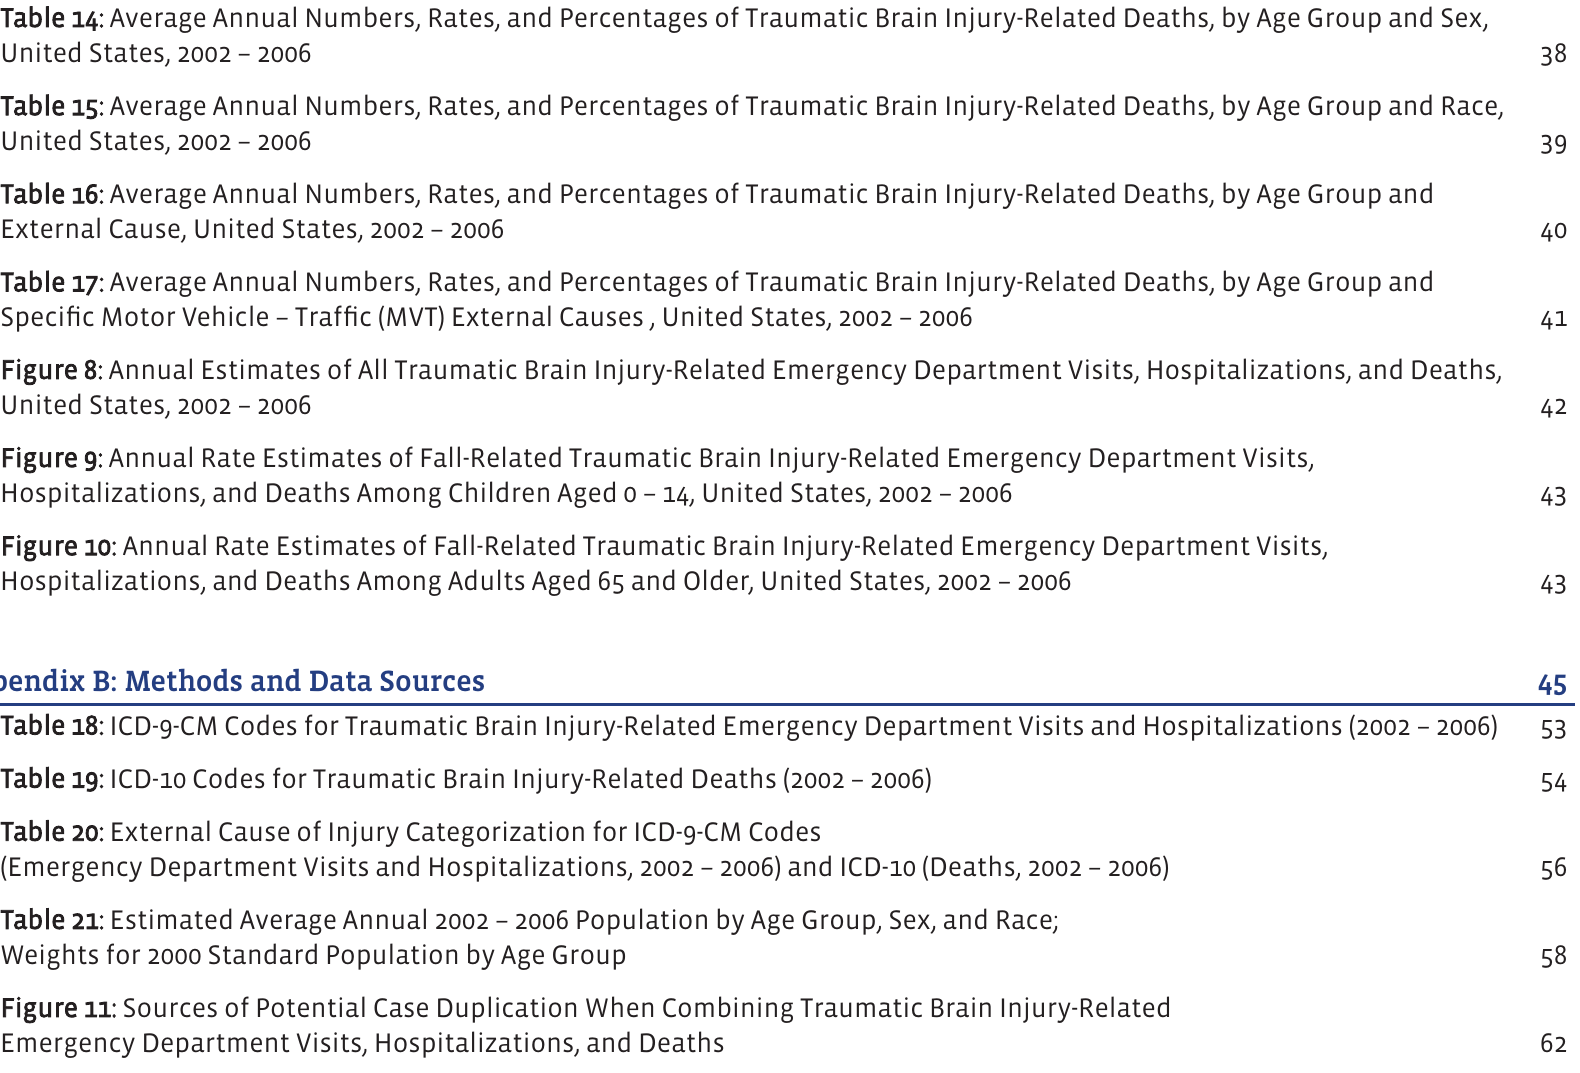
Table 20: External Cause of Injury Categorization for ICD-9-CM Codes (Emergency Department Visits and Hospitalizations, 2002 – 2006) and ICD-10 (Deaths, 2002 – 2006) Table 21: Estimated Average Annual 2002 – 2006 Population by Age Group, Sex, and Race; Weights for 2000 Standard Population by Age Group Figure 11: Sources of Potential Case Duplication When Combining Traumatic Brain Injury-Related Emergency Department Visits, Hospitalizations, and